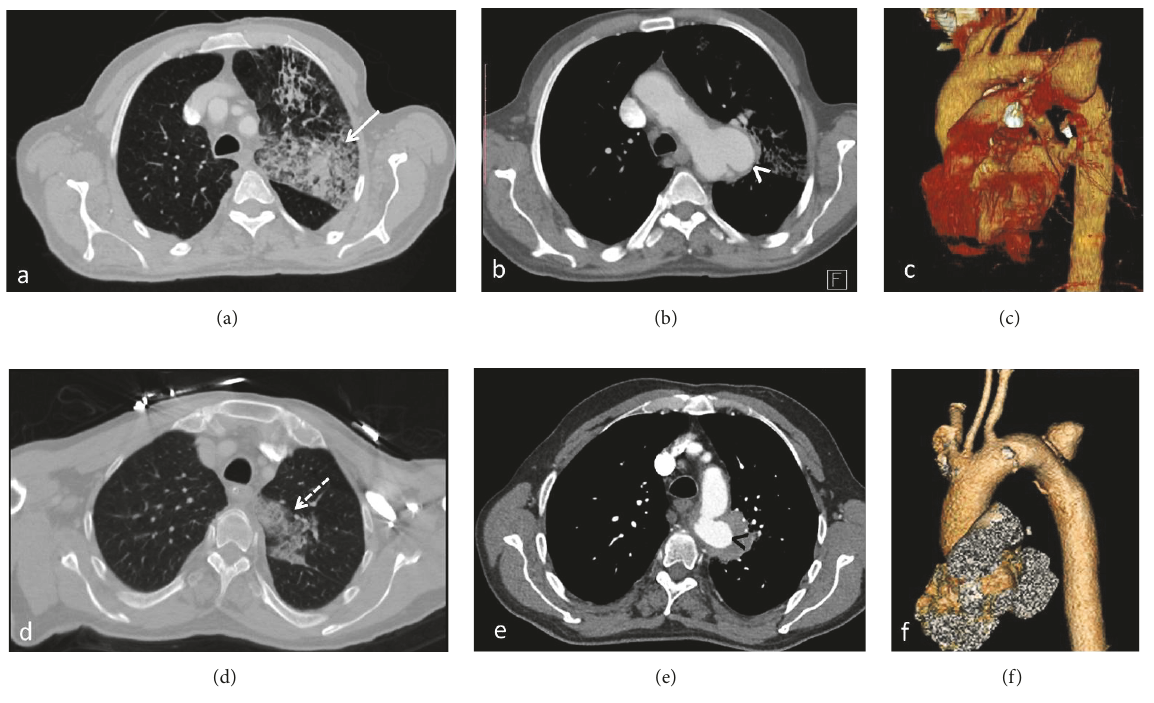
Figure 1: Case 1 (a–c). Case 2 (d–f). Contrast-enhanced CT and volume rendering technique (VRT) images revealed parenchymal hemorrhages in the left upper lungs (white arrow in (a), dashed arrow in (d)) and saccular aneurysms located proximal to the descending thoracic aorta (white arrow head in (b) and black arrow head in